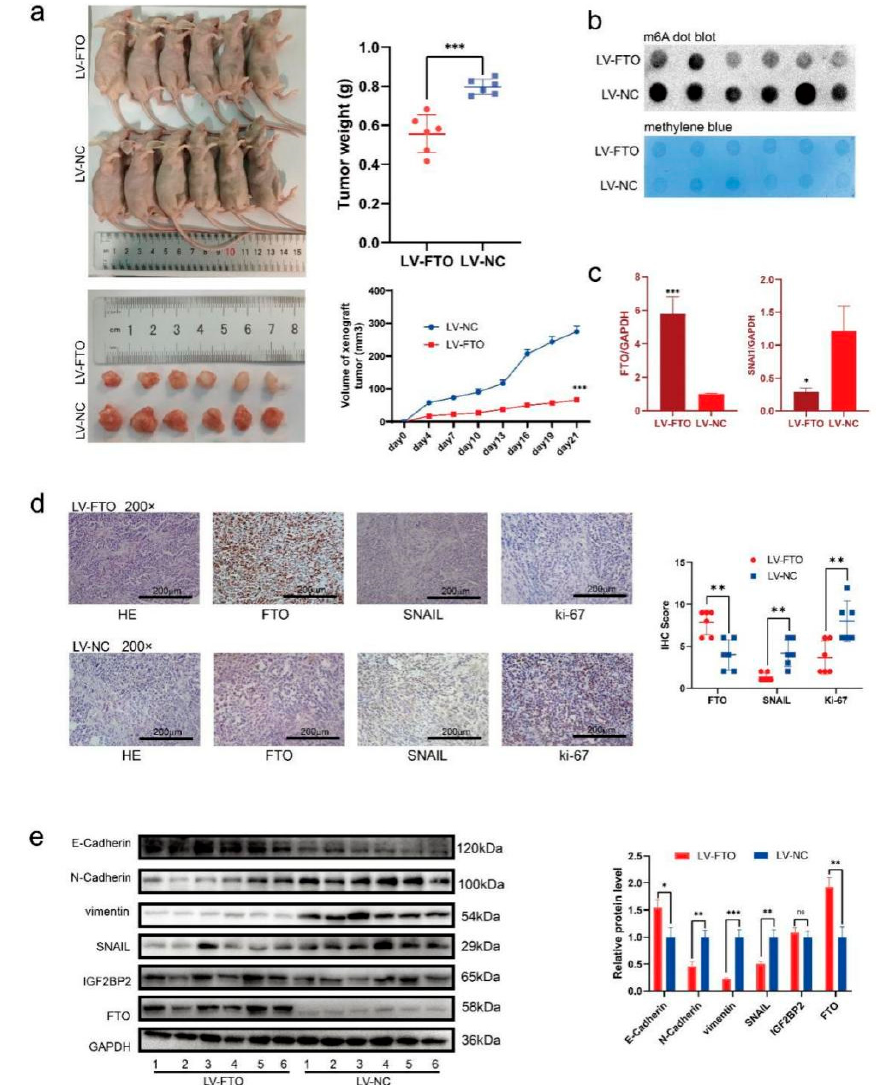
Figure 7. FTO inhibits EOC cell growth in vivo. ( a ) Representative pictures, the weight of xenograft tumours at the endpoints, and the tumour growth curves (n = 6 per group). ( b ) m6A level of xenograft tumours was detected by m6A dot blot. ( c ) RT-qPCR examined SNAI1 mRNA expression of xenograft tumours. ( d ) Representative images of IHC display the expression of FTO, SNAIL and Ki67 of xenograft tumours. Scale bar, 200 µ m. ( e ) Western blot demonstrating the expression of EMT-related markers, FTO, IGF2BP2, and SNAIL. Data are presented as mean ± SD; * p < 0.05; ** p < 0.01; *** p < 0.001. The uncropped blots are shown in Supplementary Materials File